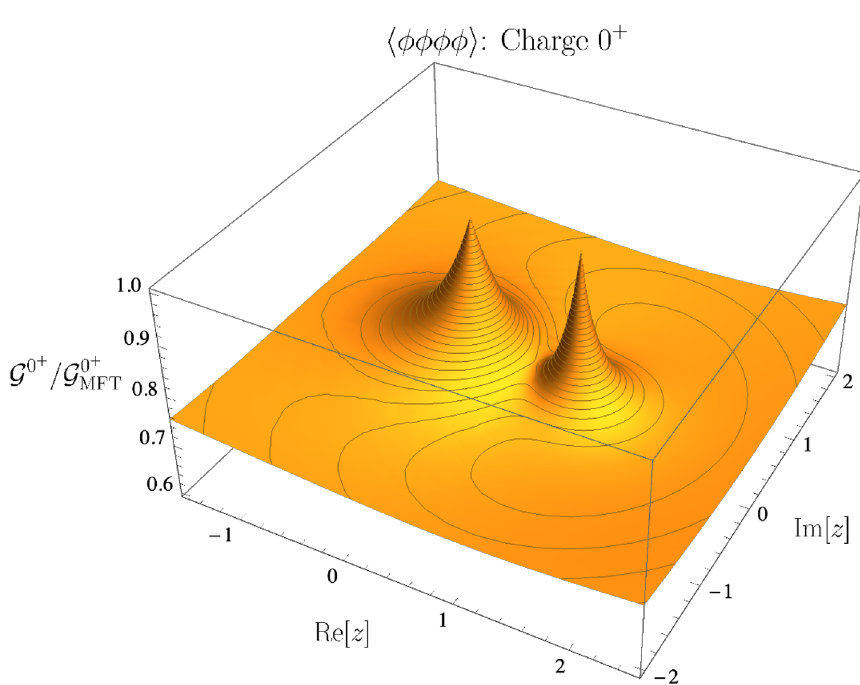
Figure 1 . We plot the Euclidean four-point function h (cid:30)(cid:30)(cid:30)(cid:30) i projected onto 0 + exchange in the s -channel and normalized by the corresponding MFT four-point function. We include both the isolated and double-twist operators and expand to 5 th order in dimensional reduction. The regions around z = 0 and z = 1 are computed using the s and t -channel,